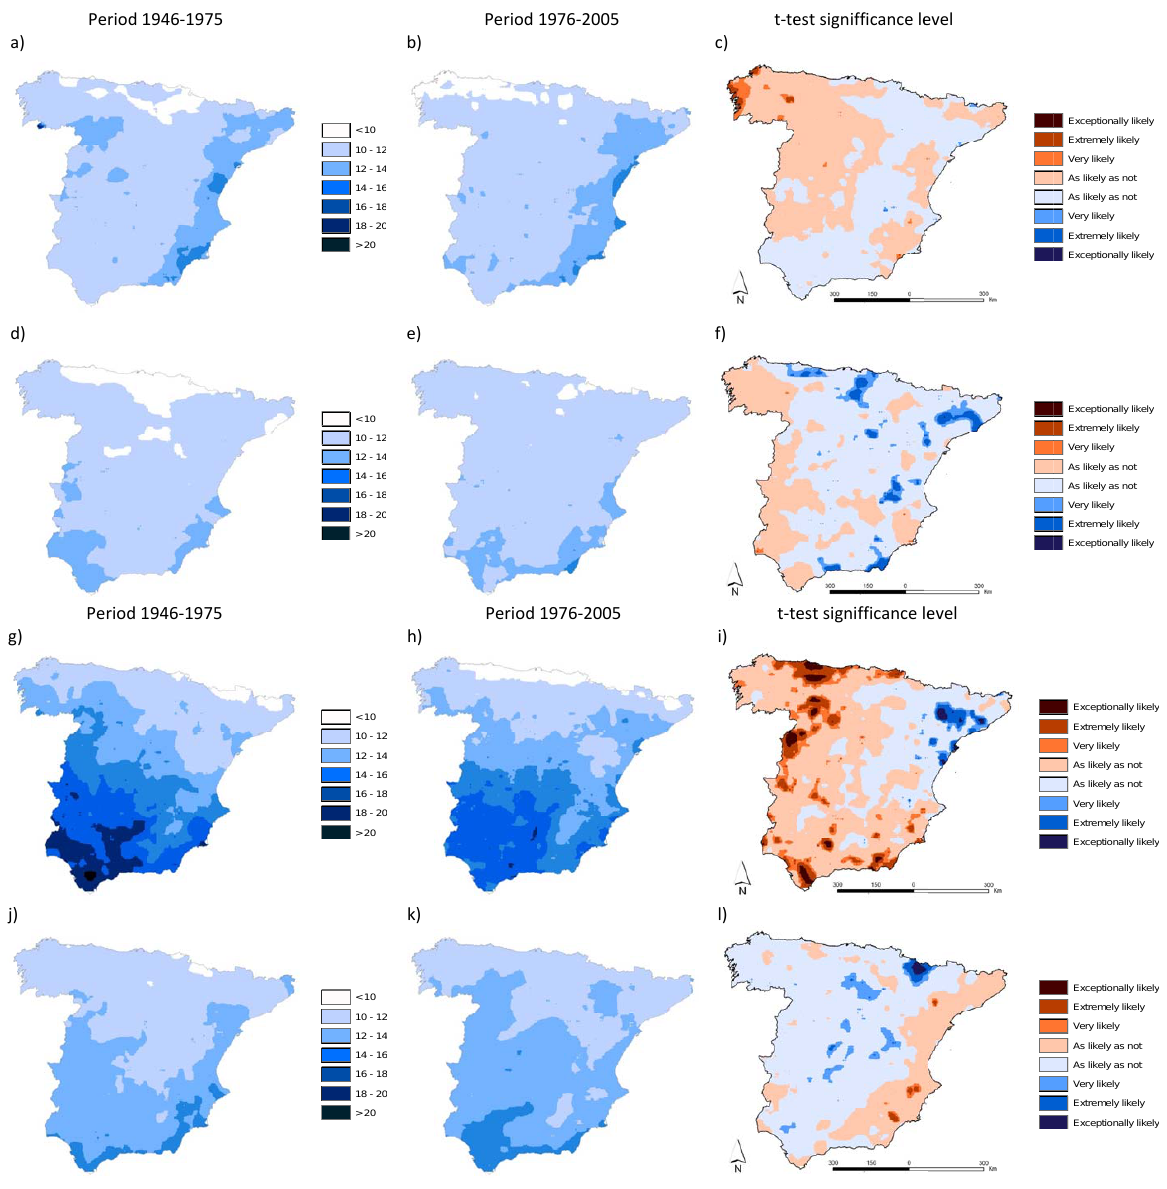
Fig. 2. Mean value of the Precipitation Concentration Index (seasonal scale) during the periods 1945–1975 and 1976–2005 and changes between periods according to different levels of probability categorized as follow: exceptionally likely ( p < 0 . 01); extremely likely ( p < 0 . 05); very likely ( p < 0 . 10); as likely as not ( p > 0 . 10). (a) , (b) (c) ) Winter; (d) , (e) , (f) ) Spring; (g) , (h) , (i) ) summer; (j) , (k) , (l) ) autumn. Blue positive, red negative